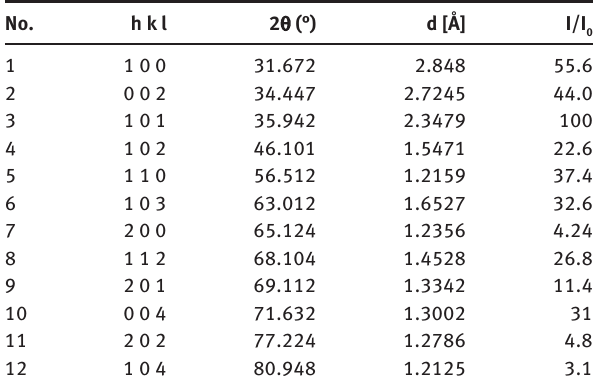
Table 1: 2 θ , d and I/I0 values of zinc oxide nanoparticles (ZnO-NPs)